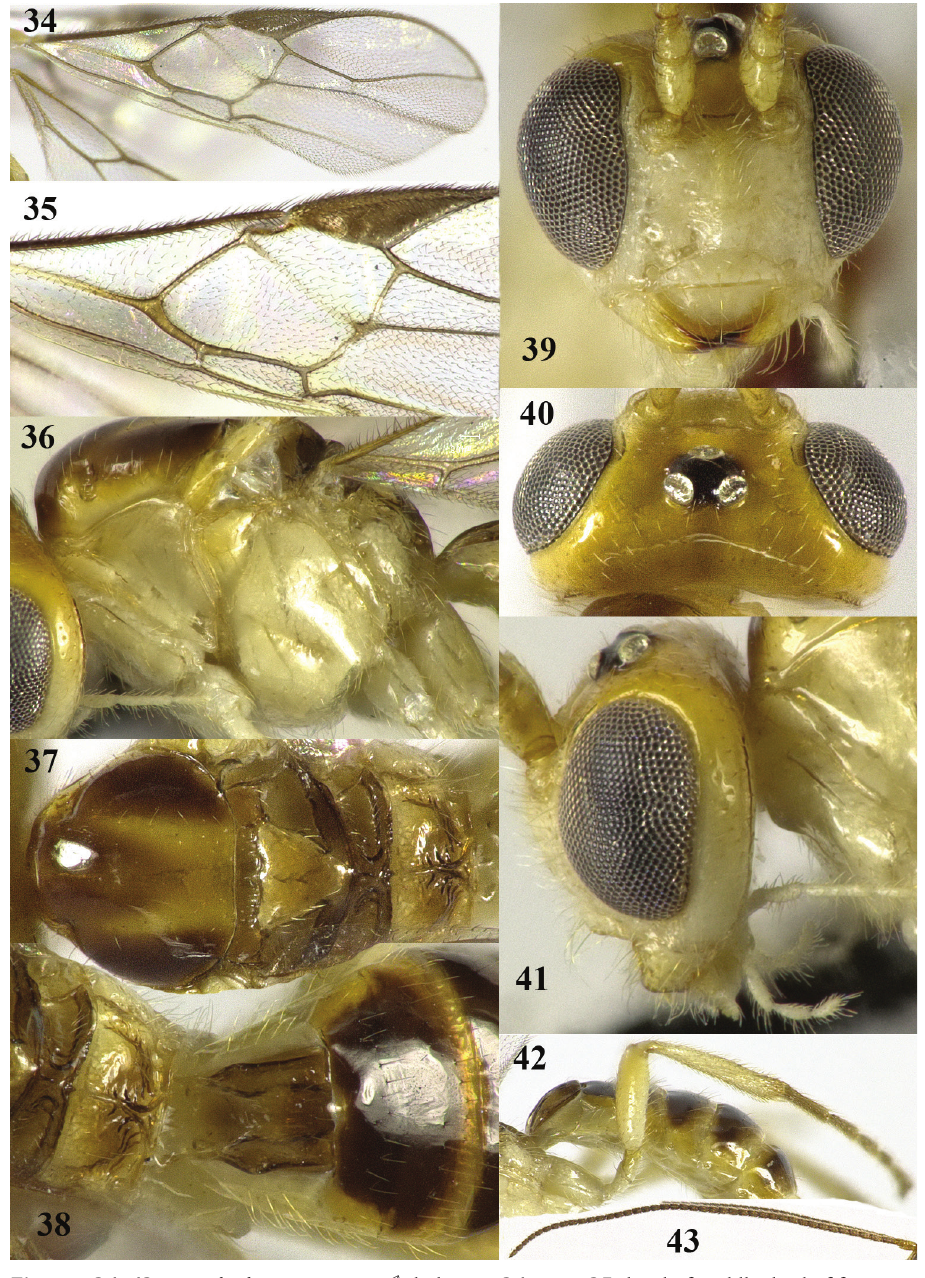
Figures 34–43. Psyttalia latinervis sp. n., ♂ , holotype. 34 wings 35 detail of middle third of fore wing 36 mesosoma lateral 37 mesosoma dorsal 38 propodeum and first–third metasomal tergites dorsal 39 head anterior 40 head dorsal 41 head lateral 42 hind leg 43